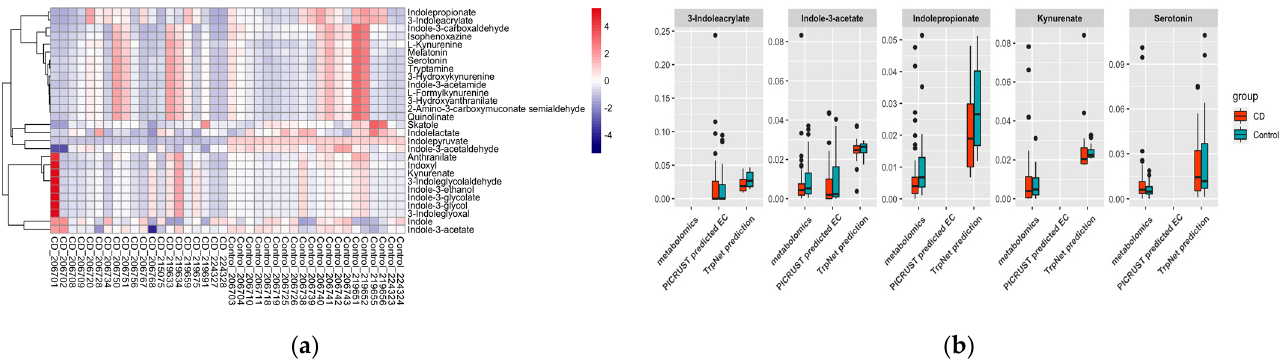
Figure 8. ( a ) Tryptophan metabolite prediction from microbiome data; ( b ) TrpNet prediction com- pared with metabolomics data and PICRUSt2